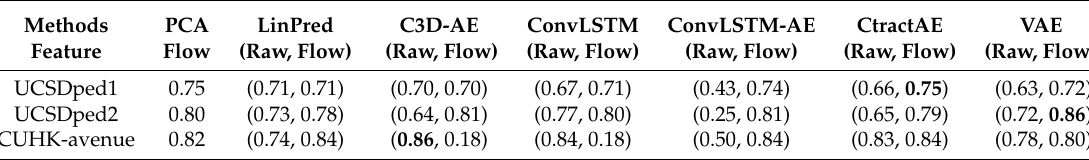
Table 1. Area Under-ROC (AUROC).